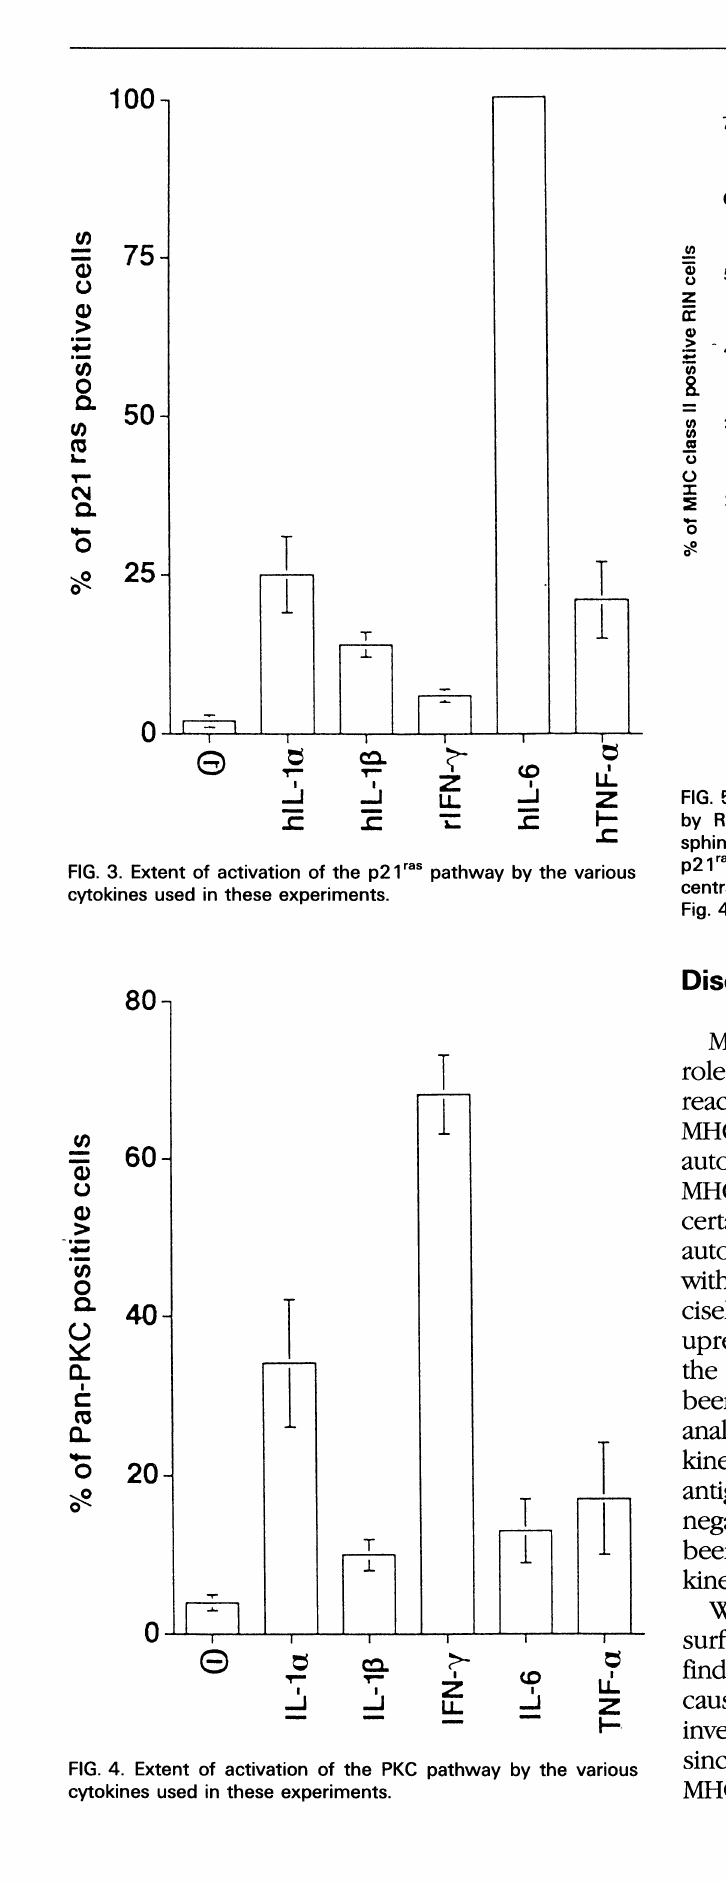
FIG. 4. Extent of activation of the PKC pathway by the various cytokines used in these